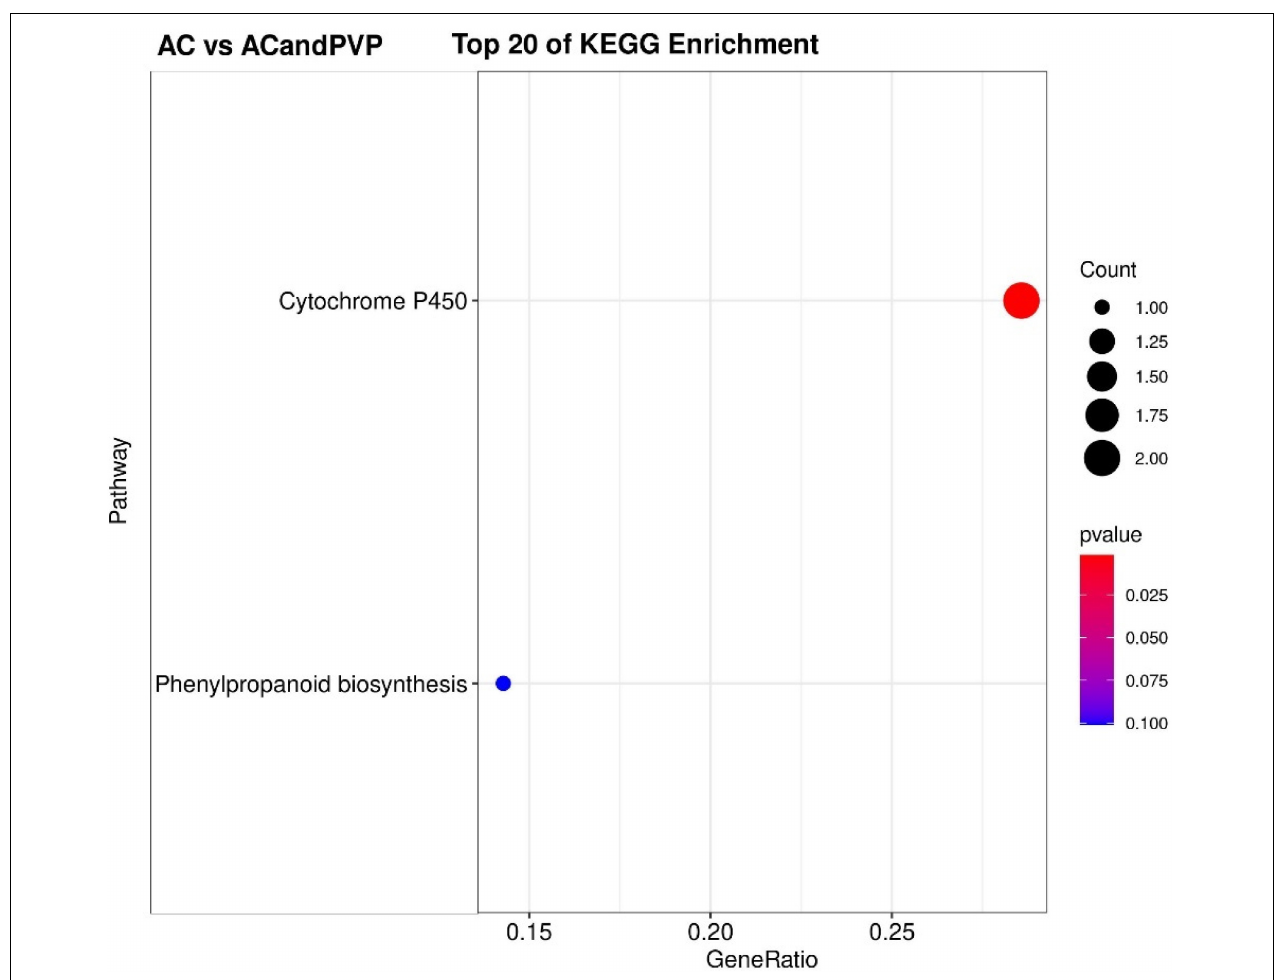
FIGURE 7 | The top 20 of the KEGG pathway enrichment of DEGs in the group of AC vs. AC and polyvinyl pyrrolidone (PVP). The first 20 pathways with the smallest P -values were used to draw the map, with pathway as the ordinate and enrichment factors as the abscissa (the number of differences in this pathway divided by all the numbers). The size of the circle indicated the number. The redder the color was, the smaller the P- value was, and the pathway representing the redder the bubbles had more